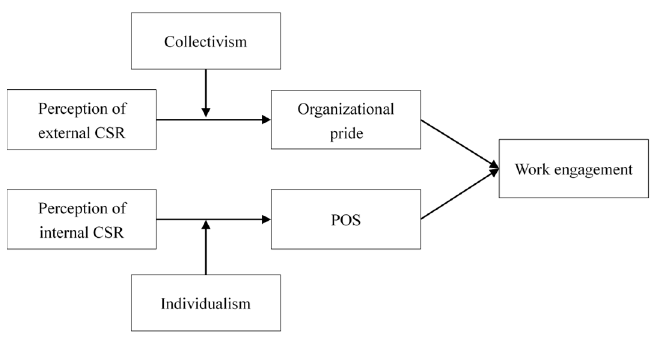
Figure 1. The conceptual model.